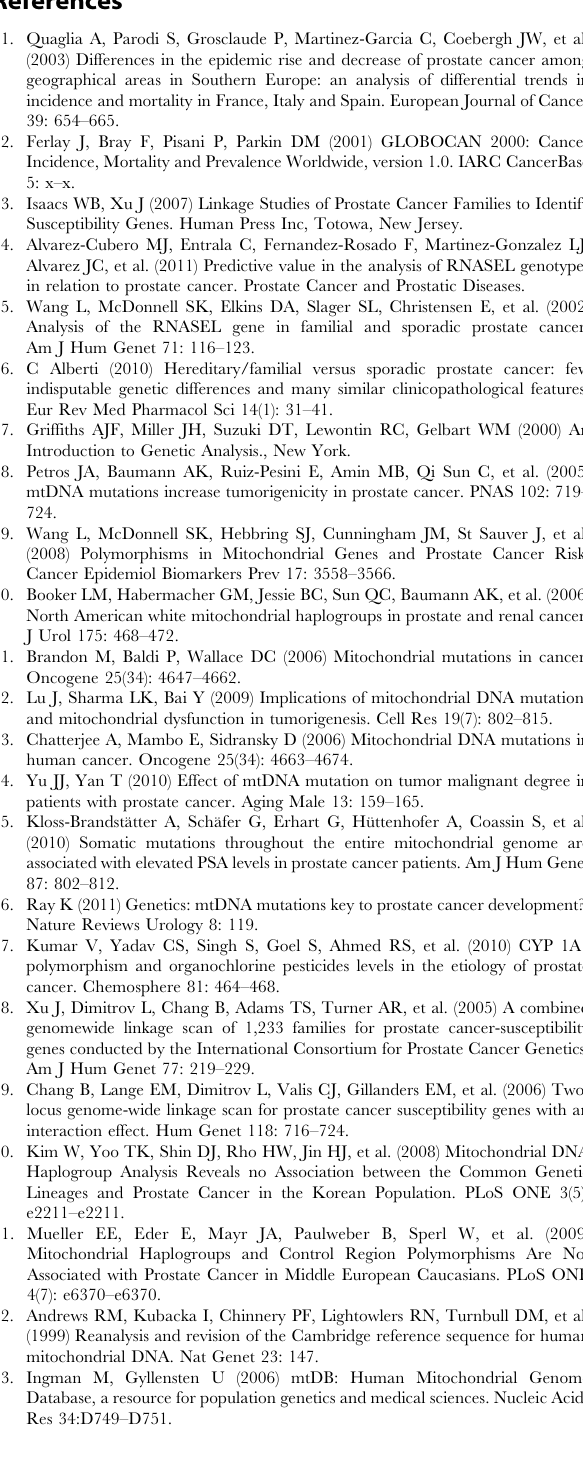
Table S3 Significant linkage disequilibrium for CR polymor-